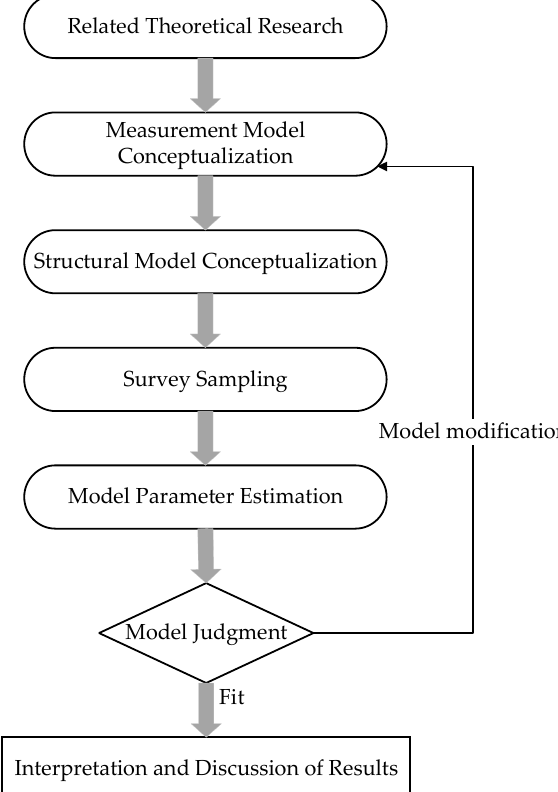
Figure 11. Structural equation model analysis of the basic procedures.